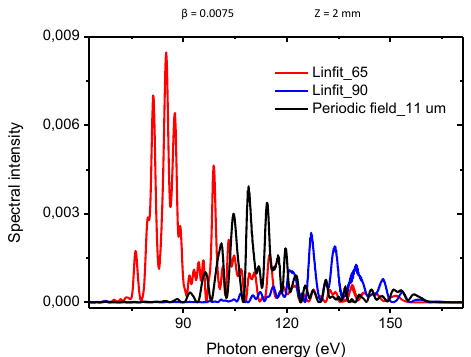
Fig. 3. Tuning of the enhanced region by using a linear